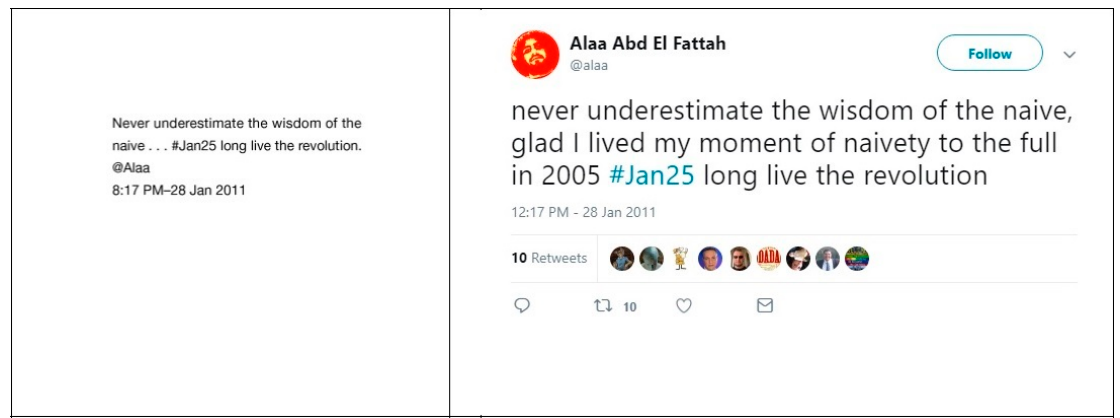
Figure 2. ( Left ) p. 3 of The City Always Wins ; ( Right ) Alaa tweet about ‘the wisdom of the naive’. 28 January 2011. Humanities 2019 , 8 , x FOR PEER REVIEW